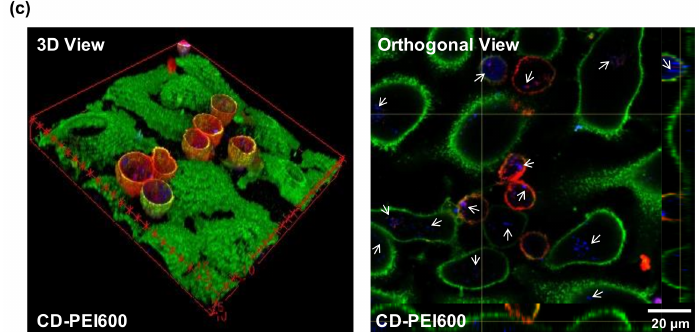
Figure 6. Uptake of CDs in the different culture models and cell types. Mono- and co-cultures (A549:THP-1 seeding ratio of 2:1) were exposed to 25 µ g/mL of CDs for 4 h, and CD-uptake was assessed by FACS or 3-D CLSM. ( a ) Gating strategy to identify the two cell types present within the co-culture and to measure CD cell uptake by FACS after cell staining with an APC-Cy7 anti-CD14 antibody (data from n = 1 experiment). ( b ) Quantification of CD internalization by FACS. Results are expressed as fold change in fluorescence intensity when compared to control cells, and are means ± SEM of n = 3 experiments. Statistical differences at p < 0.05 (one symbol), p < 0.01 (two symbols) and p < 0.001 (three symbols) were determined by ANOVA followed by the Tukey’s test when compared to control unexposed cells (asterisks) or to CD-exposed A549 cells (hash). ( c ) 3D view (left, composite of full z-stack) and orthogonal view (right, xz and yz micrograph obtained from an optical slice of a z-stack) from CLSM observation of the co-culture exposed to 25 µ g/mL of CD-PEI600 for 4 h. Cells were stained with the fluorescent membrane probe M488 and an anti-human CD14 antibody before observation. A549 cell membrane is colored in green, THP-1 cell membrane is colored in red, and CDs appear in blue and are indicated by white arrows (scale bar = 20 µ